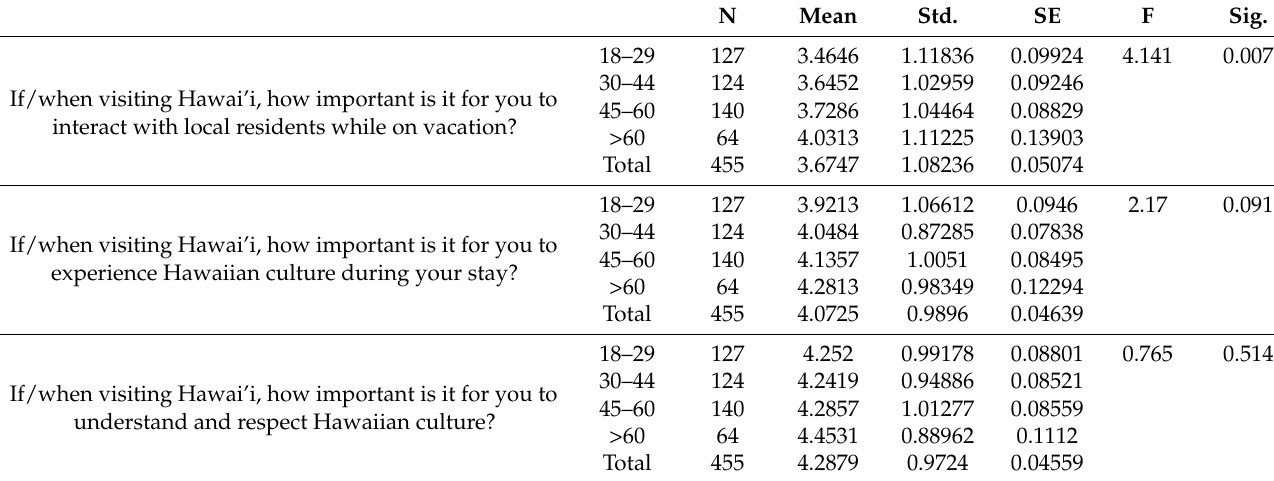
Table 4. Participants’ perceptions of the importance of encounters with Hawaiian culture, by age.